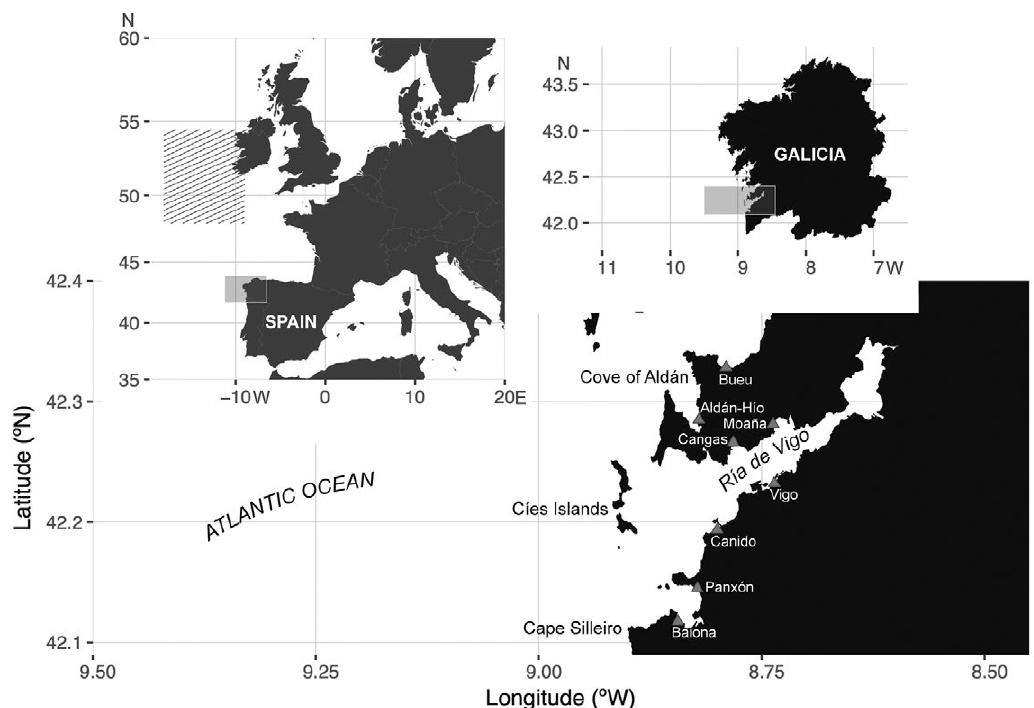
Fig. 1. – Map of the study area, composed of the Ría de Vigo, the Aldán Cove and the adjacent continental shelf, with the position of the ports where squid is landed. In striped pattern, Grand Sole fishing grounds where the Galician fishing fleet operates (48°N-54°30’N. ICES Divisions VIIb, VIIc, VIIj, VIIk). (Source: Rocha et al.